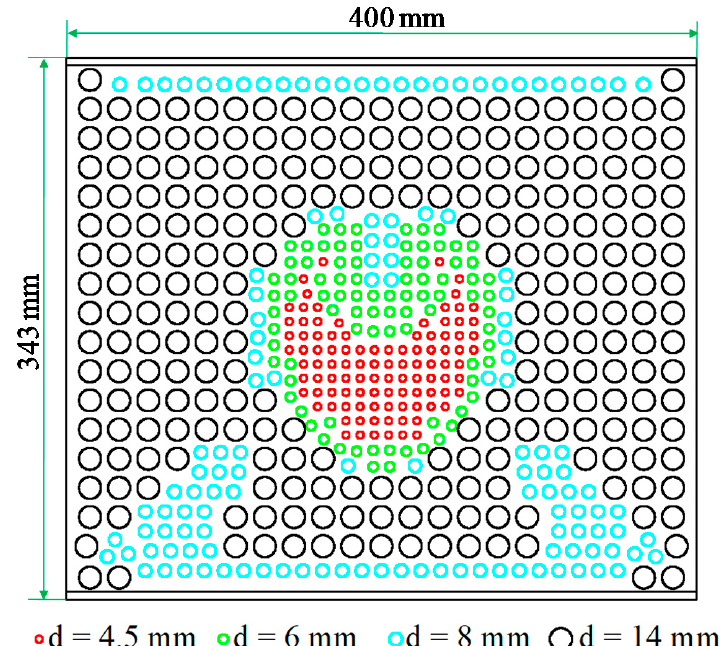
Figure 7. Final design of the perforated plate.